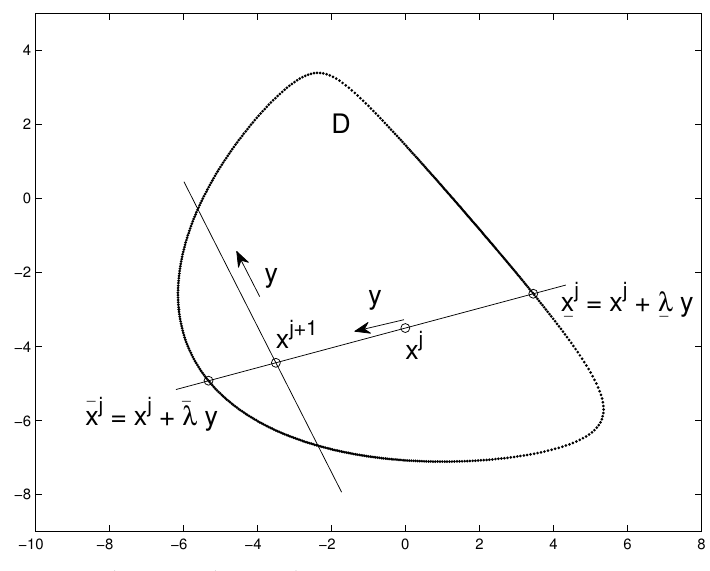
Figure 1. The Hit-and-Run